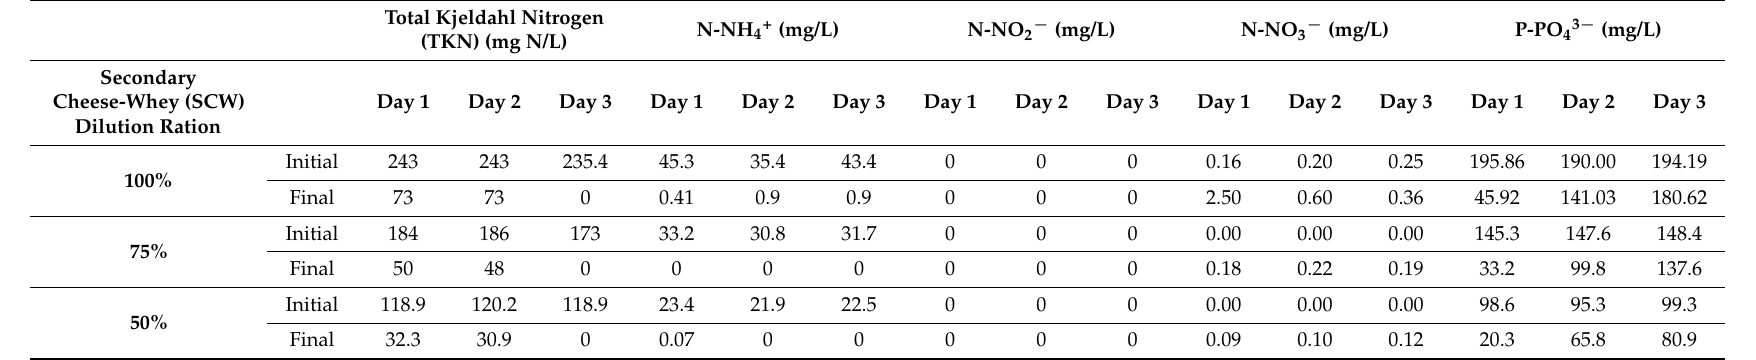
Table 6. Initial and final concentrations of nitrogen and phosphorus in the columns treating secondary cheese whey